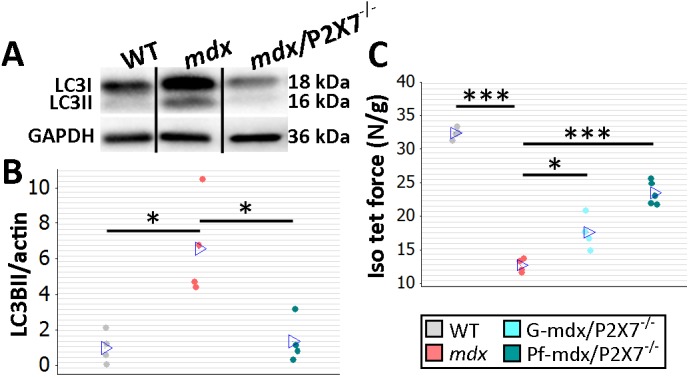

P2RX7 ablation improves mdx mouse muscles.(A) Autophagy induction (LC3I to LC3II shift in representative Western blots) found in mdx muscles is blocked in Pf-mdx/P2X7−/− muscles, with average values shown in (B) (ANOVA, F = 11.57, df = 2, n = 4, p = 0.003; Tukey’s test, Pf-mdx/P2X7−/− versus mdx, p = 0.008). Note: use of separate Western blots is indicated by solid black lines. (C) Greater average diaphragm isometric tetanic forces at 4 mo in both Pf-mdx/P2X7−/− and G-mdx/P2X7−/− compared to mdx mice (ANOVA, F = 37.97, df = 2, n = 4, 4, 5, p < 0.001; Tukey’s test, G-mdx/P2X7−/− versus mdx, p = 0.010; Pf-mdx/P2X7−/− versus mdx, p < 0.001). *p < 0.05, ***p < 0.001.